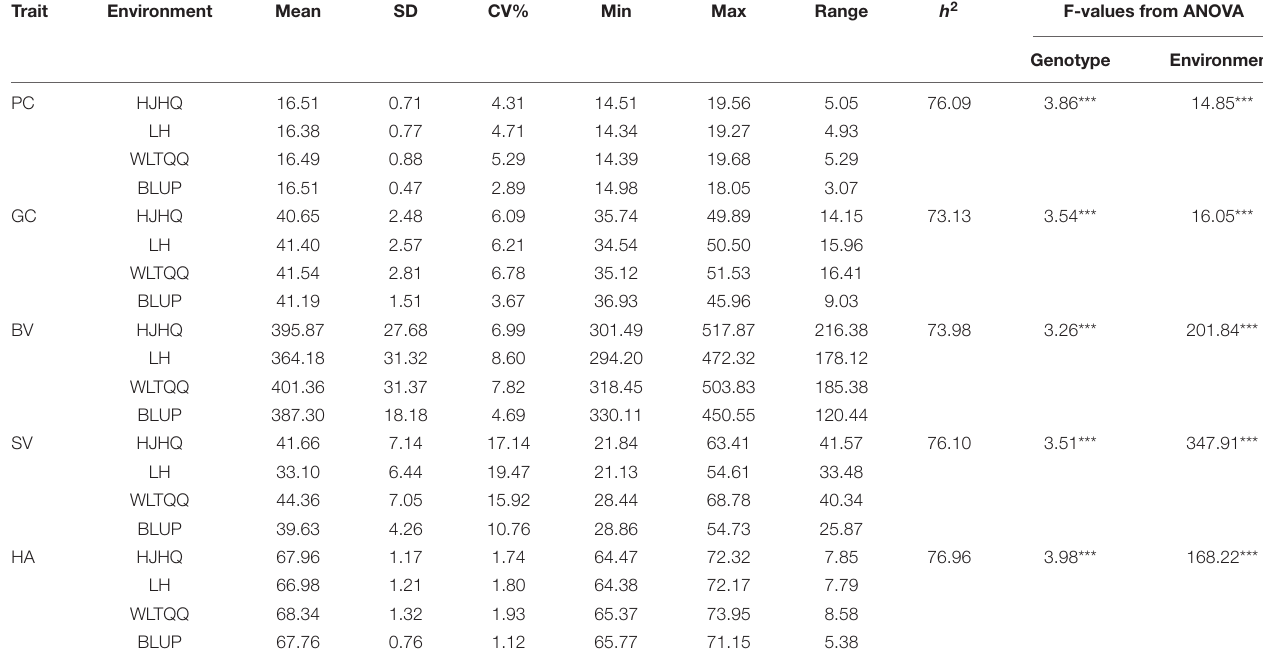
TABLE 2 | Descriptive statistics, broad-sense heritability, and analysis of variance for the five quality traits in the association panel. Trait Environment F-values from ANOVA